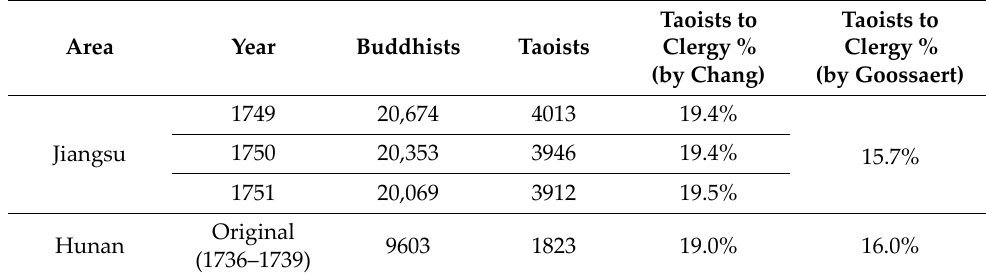
Table 6. The proportion of monks and Taoists with ordination certificates in Zhejiang, Shanxi, and Gansu provinces in the mid‑18th